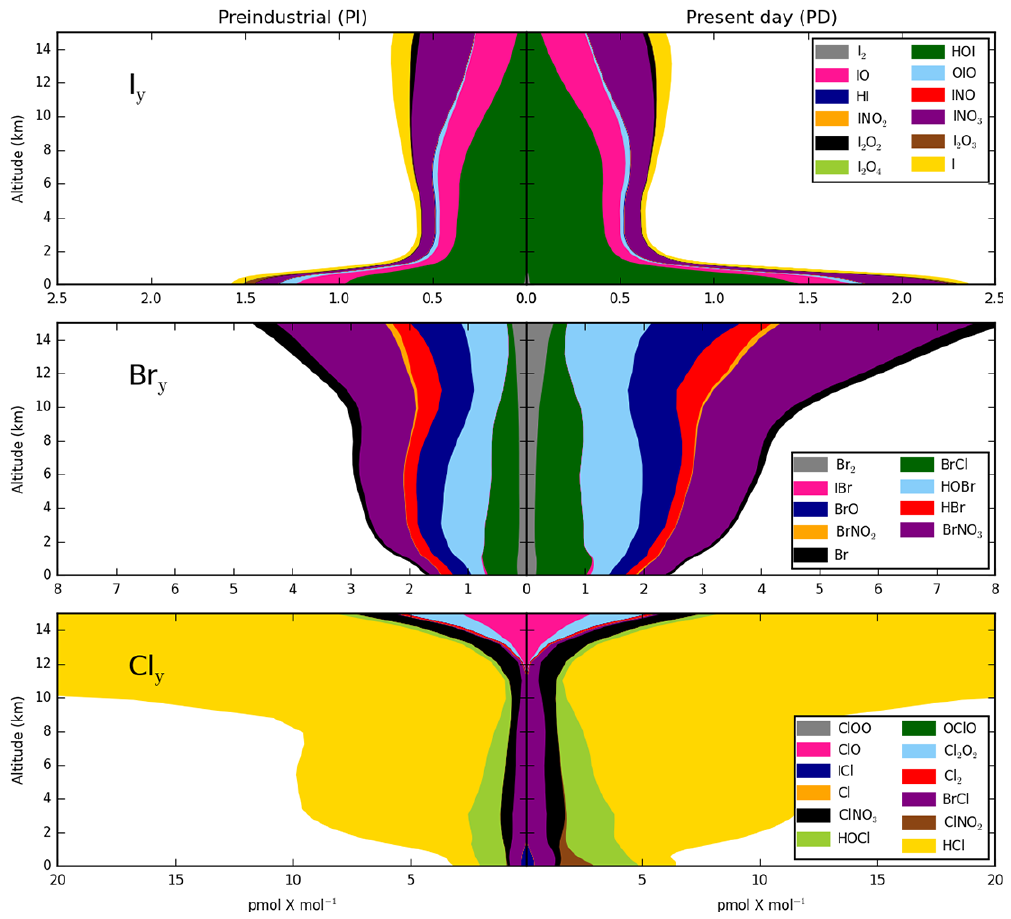
Figure 3. Global mean vertical distribution of iodine, bromine, and chlorine inorganic gases (X y , X = Cl, Br, I) for the preindustrial (left) and present day (right) in terms of mixing ratios of halogen. Increased halogen concentrations in the present day are predominantly at the surface for iodine but are throughout the column for bromine and chlorine. Table 2. Odd oxygen (O x ) family definition used